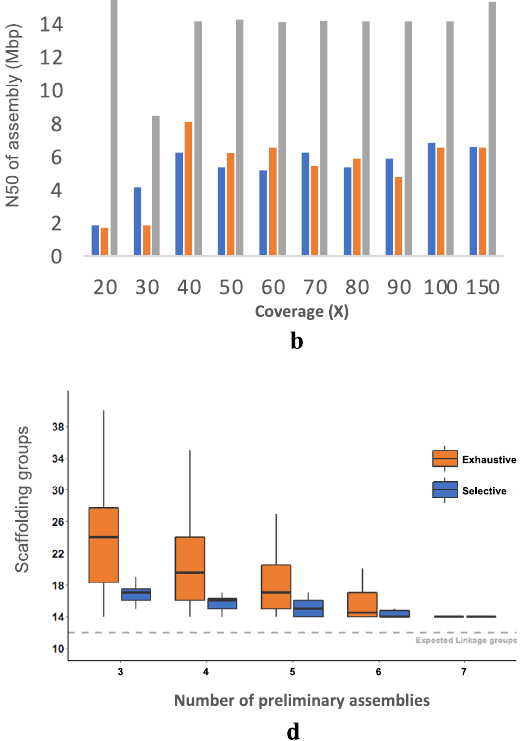
Fig. 5 | The assembly performances of GALA changes with the coverages of sequencing data and with the number and the quality of preliminary assem- blies. Toinvestigatetheeffectofsequencingcoverage,threeassemblyprocedures havebeentestedusing C.elegans PacBiosequencingdata:GALAwithoutHi-Cdata, Flye/Hi-C and GALA/Hi-C. The assembly performances are evaluated in terms of a thenumberof scaffolds, b N50,and c the numberofbiggaps(>16Kbp)and mis- assemblies. In ( c ), only the number of gaps and mis-assemblies for Flye/Hi-C have been shown for simplicity, as GALA shows overwhelming advantage and only one